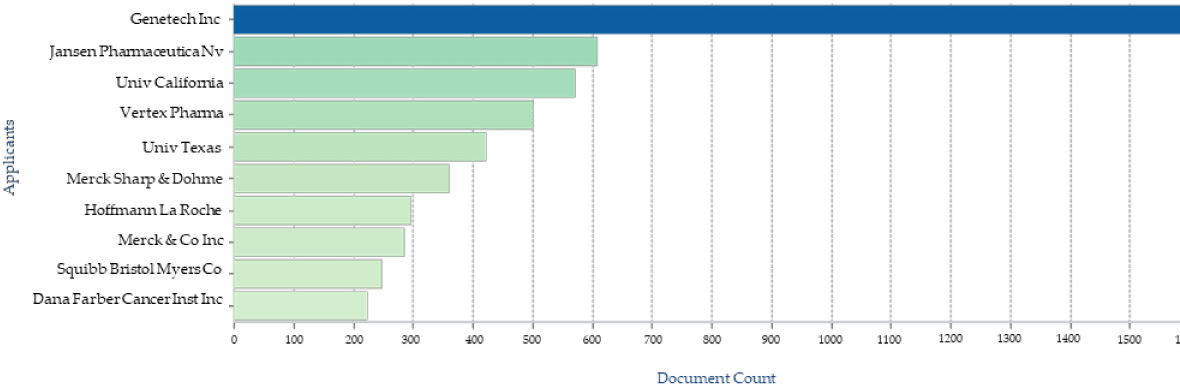
Figure 10. Key patent filing companies on podophyllotoxin.